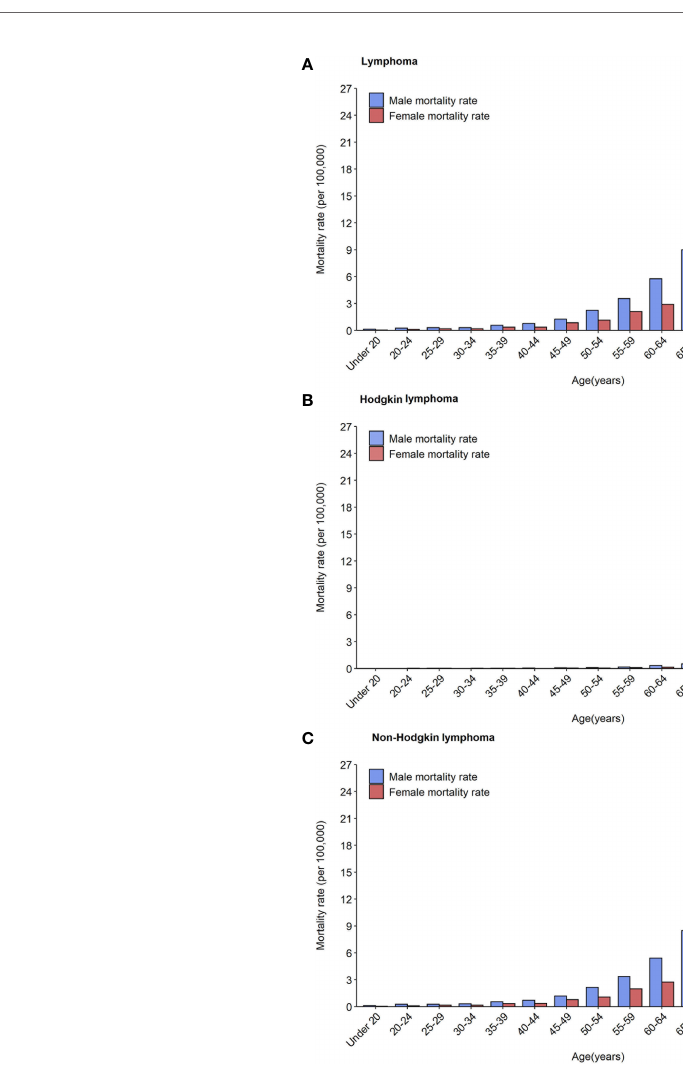
FIGURE 1 | Mortality rates of lymphoma (A) , Hodgkin lymphoma (B) and non-Hodgkin lymphoma (C) by age groups and sex in